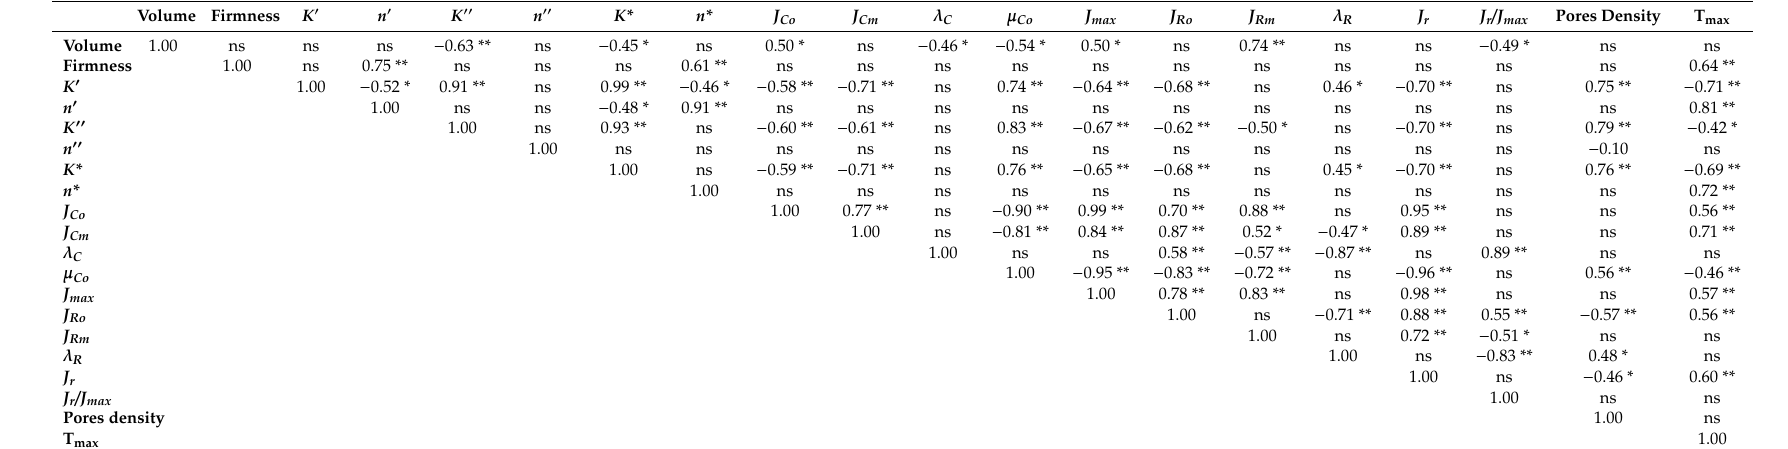
Table 6. Correlations between dough and bread